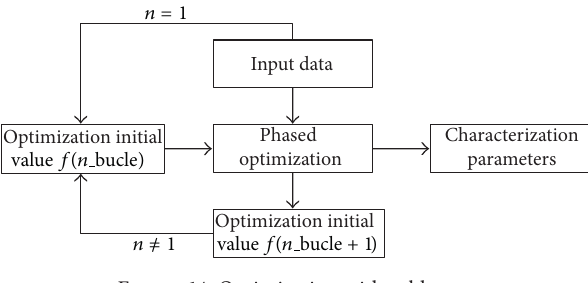
Figure 14: Optimization with subloops. Table 4: Discretization of the work space of the rotational